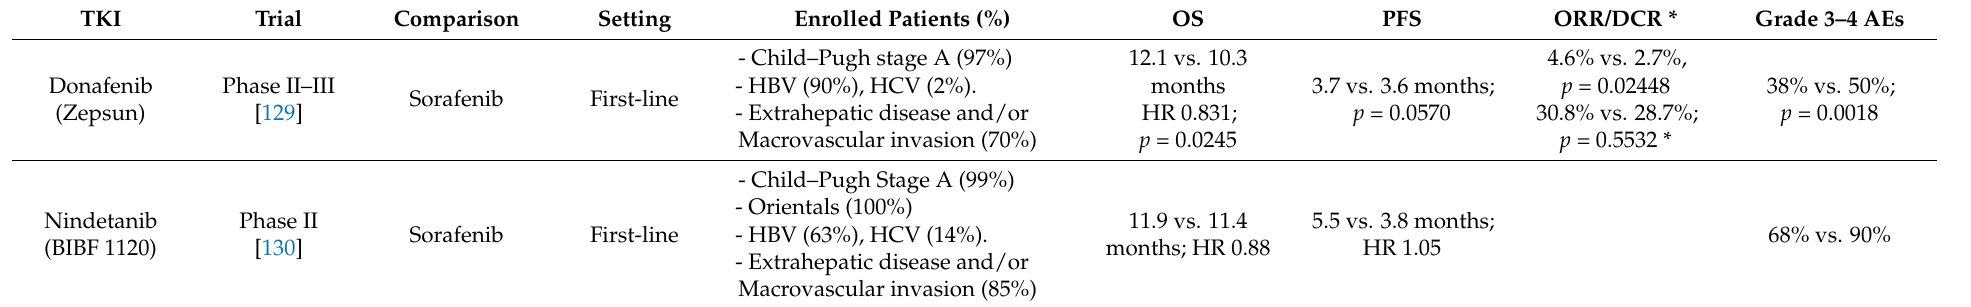
Table 3. Other tyrosine kinase inhibitors for the treatment of advanced HCC.